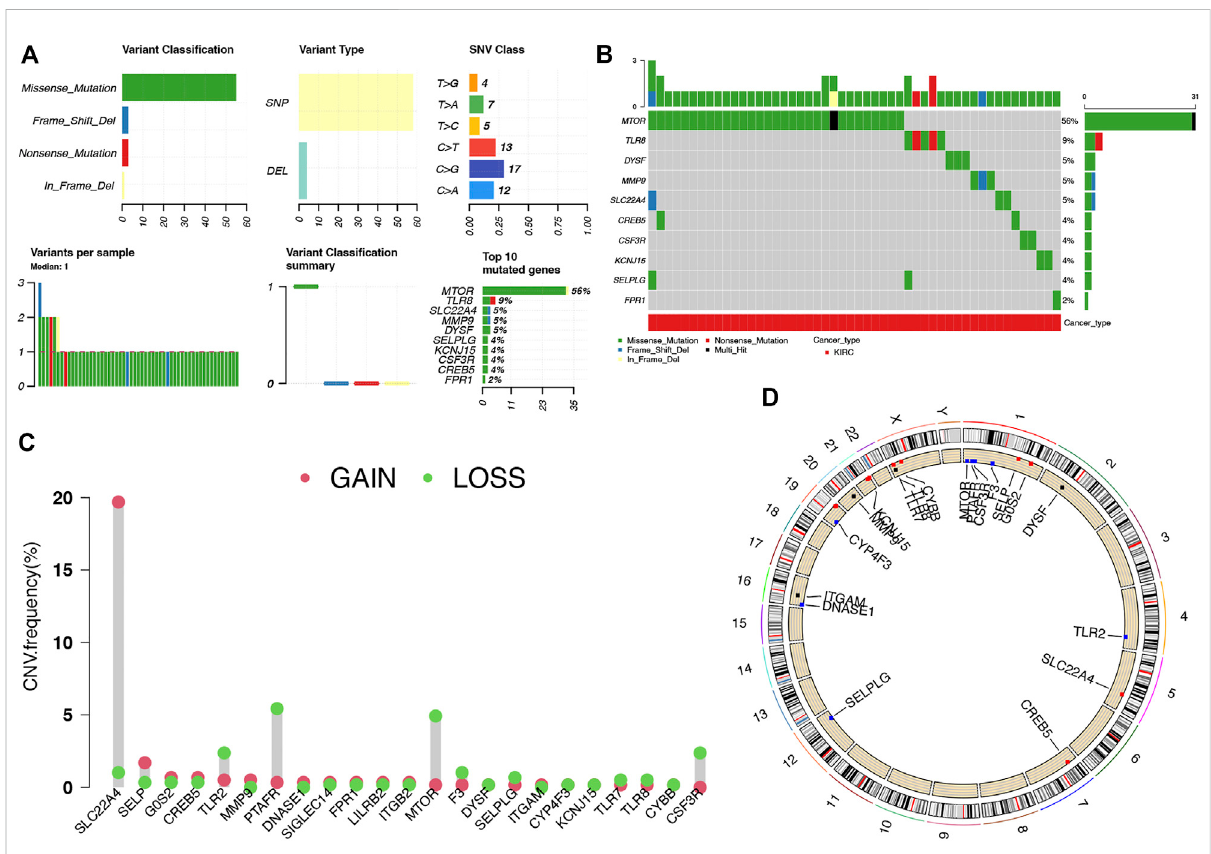
FIGURE 2 Landscape of genetic mutation of NET-related genes in ccRCC. (A – B) SNV frequency and classi fi cation of NET-related genes in LUAD. (C – D) CNV alteration of NET-related genes in ccRCC and their location on chromosomes. NETs, neutrophil extracellular traps; ccRCC, clear cell renal cell